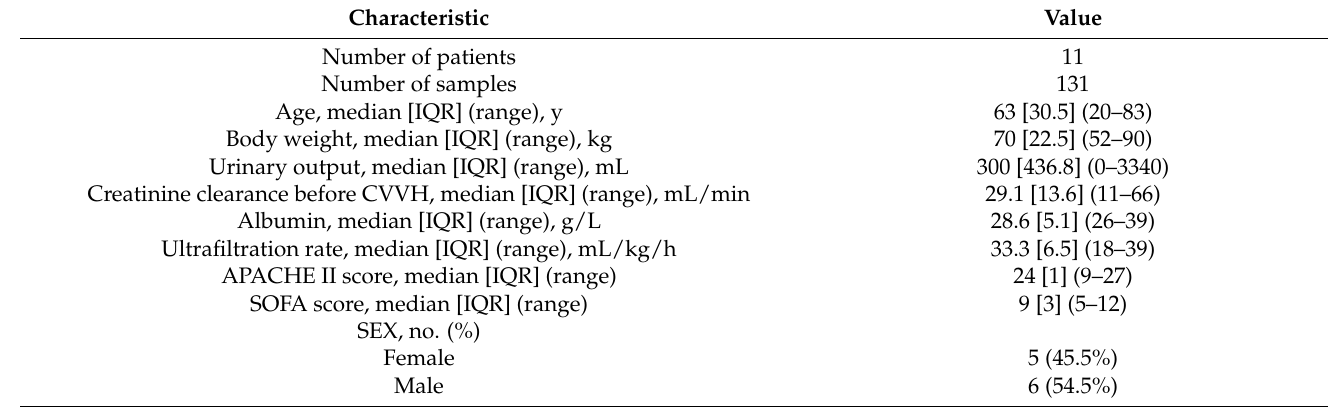
Table 1. Demographic and clinical characteristics of 11